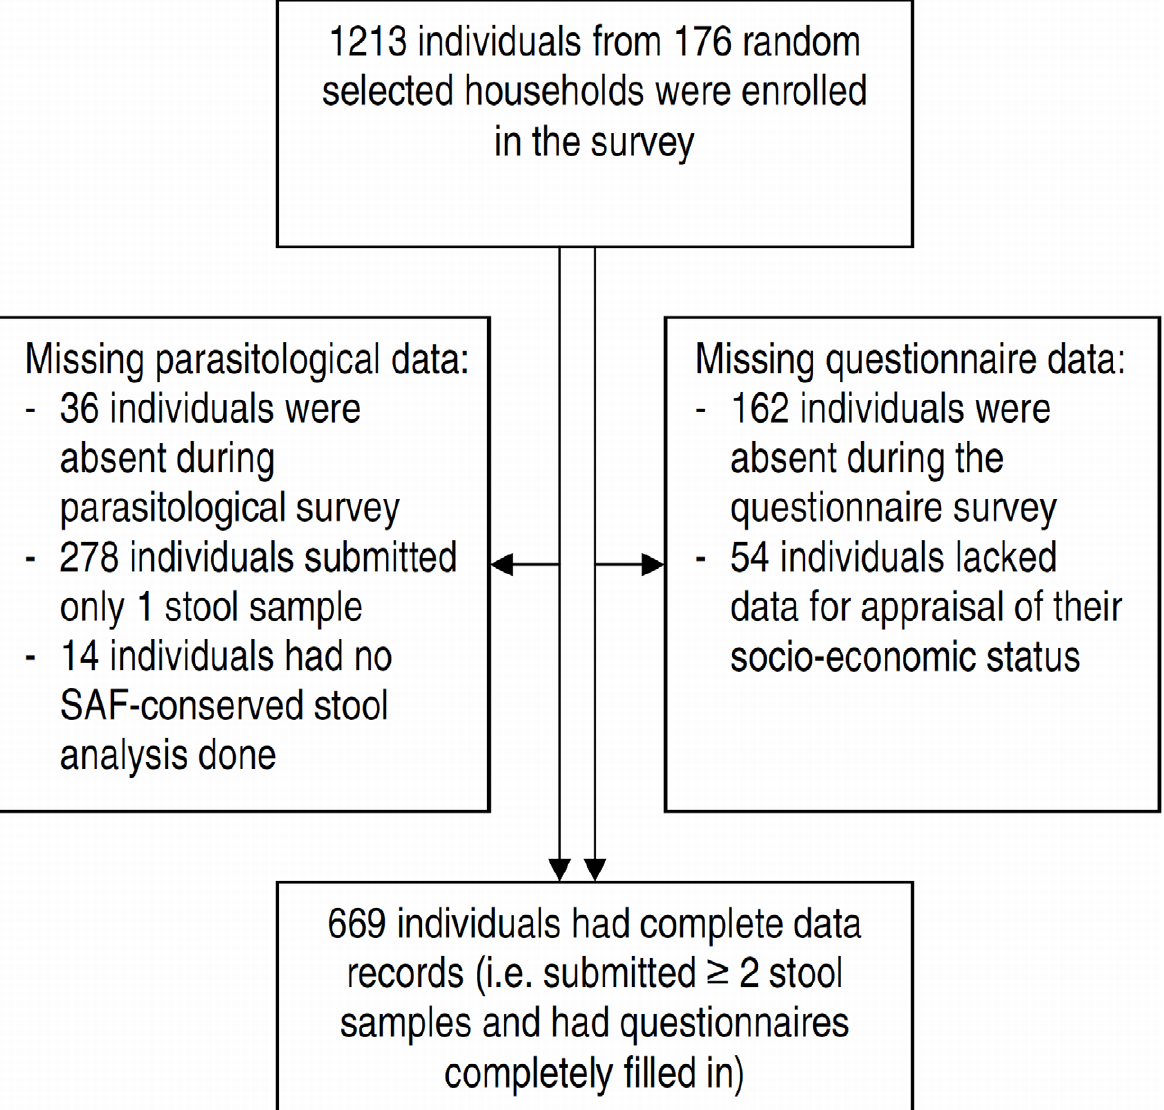
Figure 2. Study participants ’ compliance of survey in three eco-epidemiological settings of Champasack, southern Lao PDR.